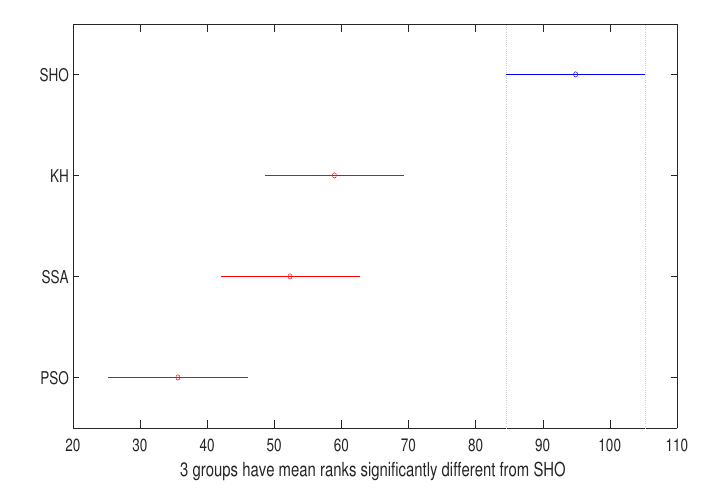
Figure 4. F1 score Tukey